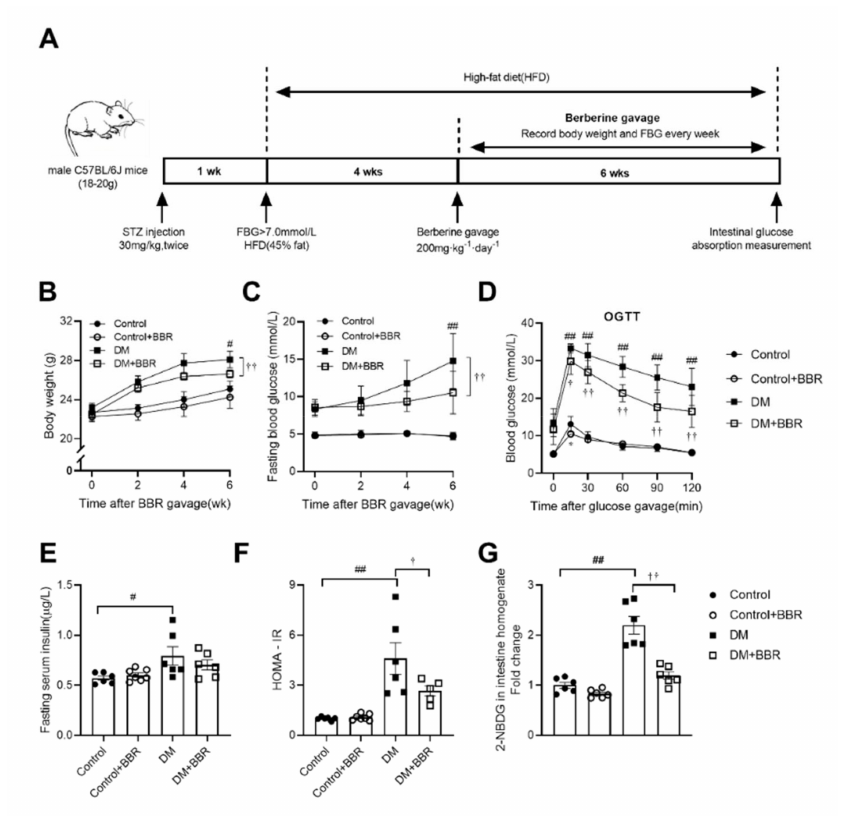
(Figure 1E,F). In order to evaluate the effect of berberine on intestinal glucose absorption directly, we observed the glucose transport capacity of intestine by 2-NBDG transport experiment ex vivo and found that ability of intestinal glucose absorption of diabetic mice was enhanced by 2.2 times compared to mice in the control group (Figure 1G). After berber- ine gavage treatment for 6 weeks, the ability of intestinal glucose absorption of mice in the DM + BBR group was decreased by 45.7% compared to the DM group (Figure 1G). Moreover, we found that glucose level in feces, which was normalized by food intake and body weight, was decreased by 30.4% in diabetic mice compared to mice in the control group and increased by 70.6% in mice in the DM + BBR group compared to mice in the DM group (Figure S1). Previous studies have shown high fat diet induced overgrowth of intestinal villus [19]. To ex- amine berberine’s effect on intestinal epithelium, intestinal villus length and crypt depth were assessed using HE staining. After berberine treatment (200 mg · kg − 1 · day − 1 , BW) for 6 weeks, the intestinal crypt depth, but not villus length, was decreased in berberine treated diabetic mice (Figure S2). Besides beneficial effects of long-term administration of berberine on intestinal glucose absorption, we further tested instant effects by OGTT after single dose administration of berberine with glucose and found that a single dose gavage of berberine (200 mg · kg − 1 , BW) decreased postprandial blood glucose in OGTT in normal mice (Figure S3).